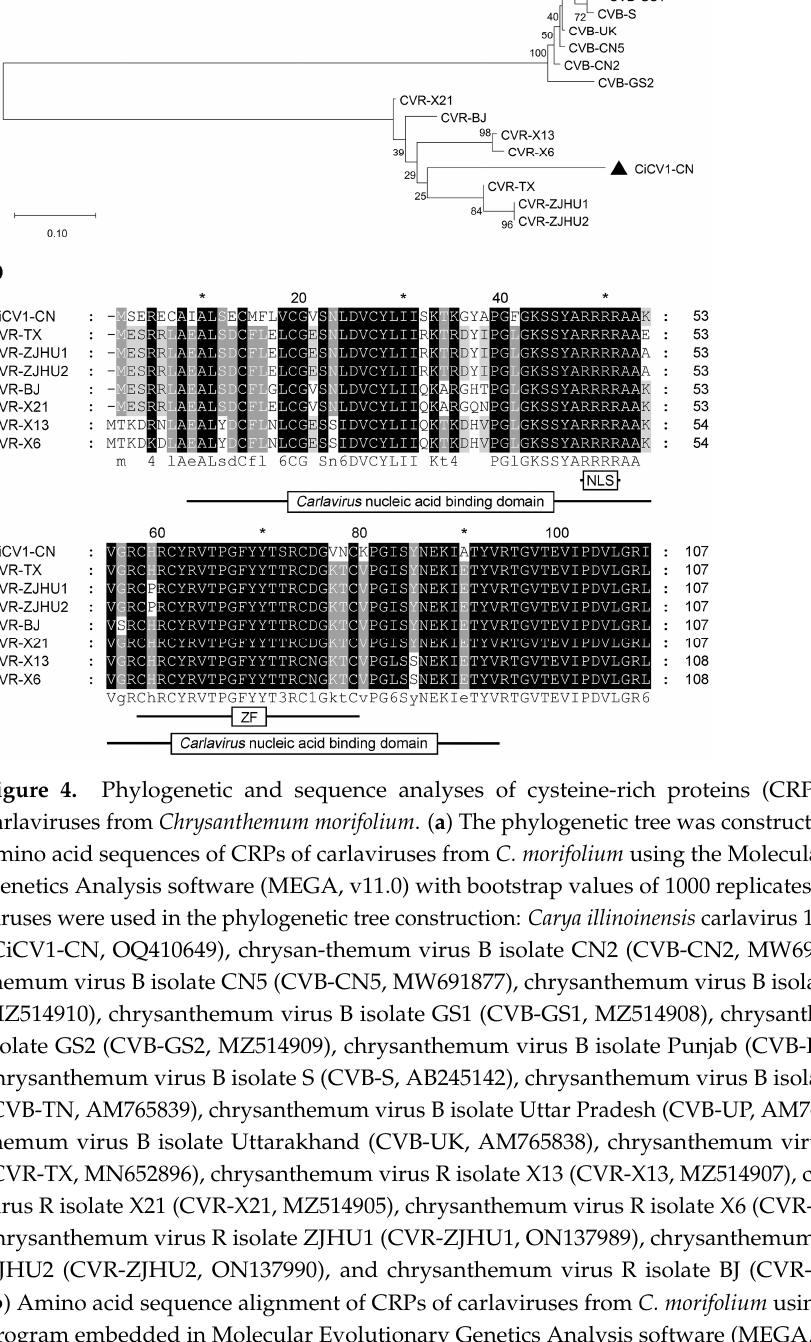
Amino acid sequence alignment of CRPs of carlaviruses from C. morifolium using the ClustalW pro- gram embedded in Molecular Evolutionary Genetics Analysis software (MEGA, v11.0), and the con- served domains were determined using the InterPro (http://www.ebi.ac.uk/interpro/ (accessed on 30 August 2022)). The following viruses were used in the amino acid sequence alignments: Carya